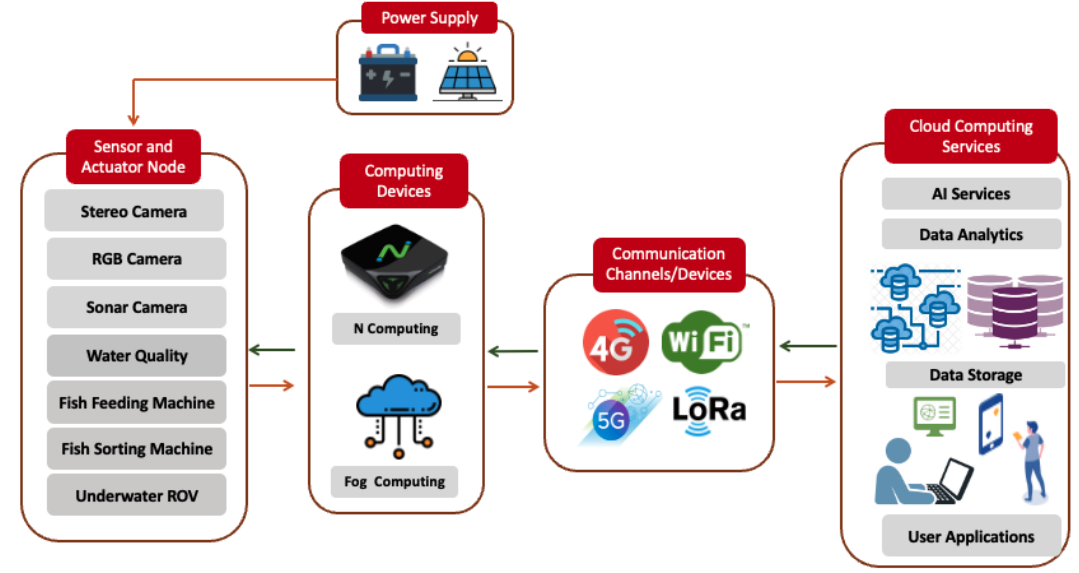
Figure 1. Schematic view of the proposed AIoT system for intelligent fish farming [8].